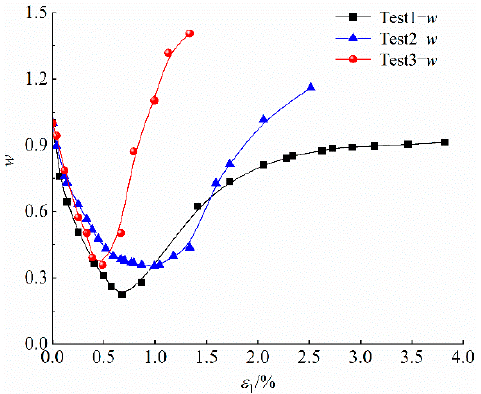
Figure 7. Relative permeability change.